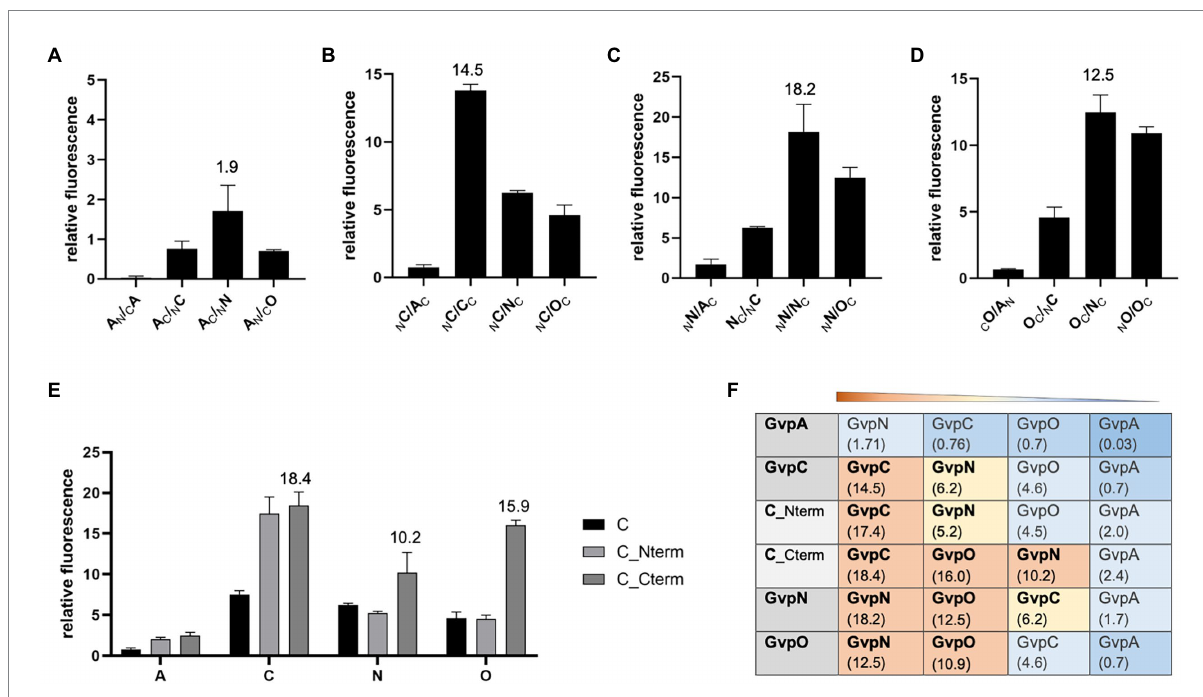
FIGURE 3 Split-GFP analyses to investigate the interaction of GvpA, C, N, and O. The relative fluorescence (rf) is given in LAU/mm 2 . In each case, only the combination resulting in the highest rf value is presented, and the position of the GFP-tag can be deduced from the place of the subscript N (for NGFP) or C (CGFP) at the left (N-terminal) or right side (C-terminal) of the respective Gvp protein. All experiments were performed in two biological and three technical replicates ( n = 6). The relative fluorescence was calculated in relation to the fluorescence of Hfx. volcanii wild type. The error bars represent the standard deviation of the rf values of the biological/technical replicates. (A) Interaction of GvpA with GvpA, C, N, or O; (B) Interaction of GvpC with GvpA, C, N, or O; (C) Interaction of GvpN with GvpA, C, N, or O; (D) Interaction of GvpO with GvpA, C, N, or O; (E) Interaction of GvpC fragments Cterm and Nterm with GvpA, C, N, or O. (F) Overview of the rf values for each of these interactions. The Gvp proteins interacting with the respective Gvp protein placed on the left (shaded in grey) are ordered by rf values and shaded in red, rf > 10; yellow, rf < 10 to >5; blue, rf < 5; dark blue, rf <